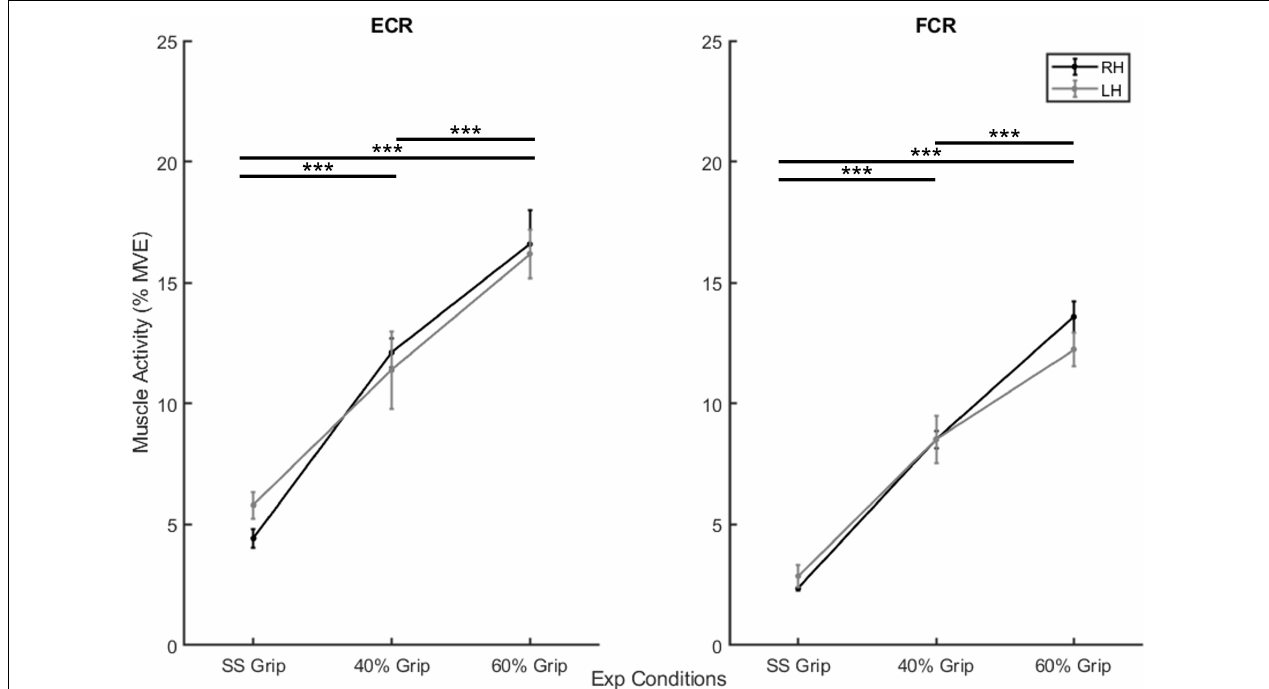
FIGURE 2 | Mean muscle activity (%MVE) for extensor carpi radialis (ECR) (left) and flexor carpi radiali (FCR) (right). Black and gray lines represent RH and LH group, respectively. Mean ± std. ***, statistically significant, p < 0.001.